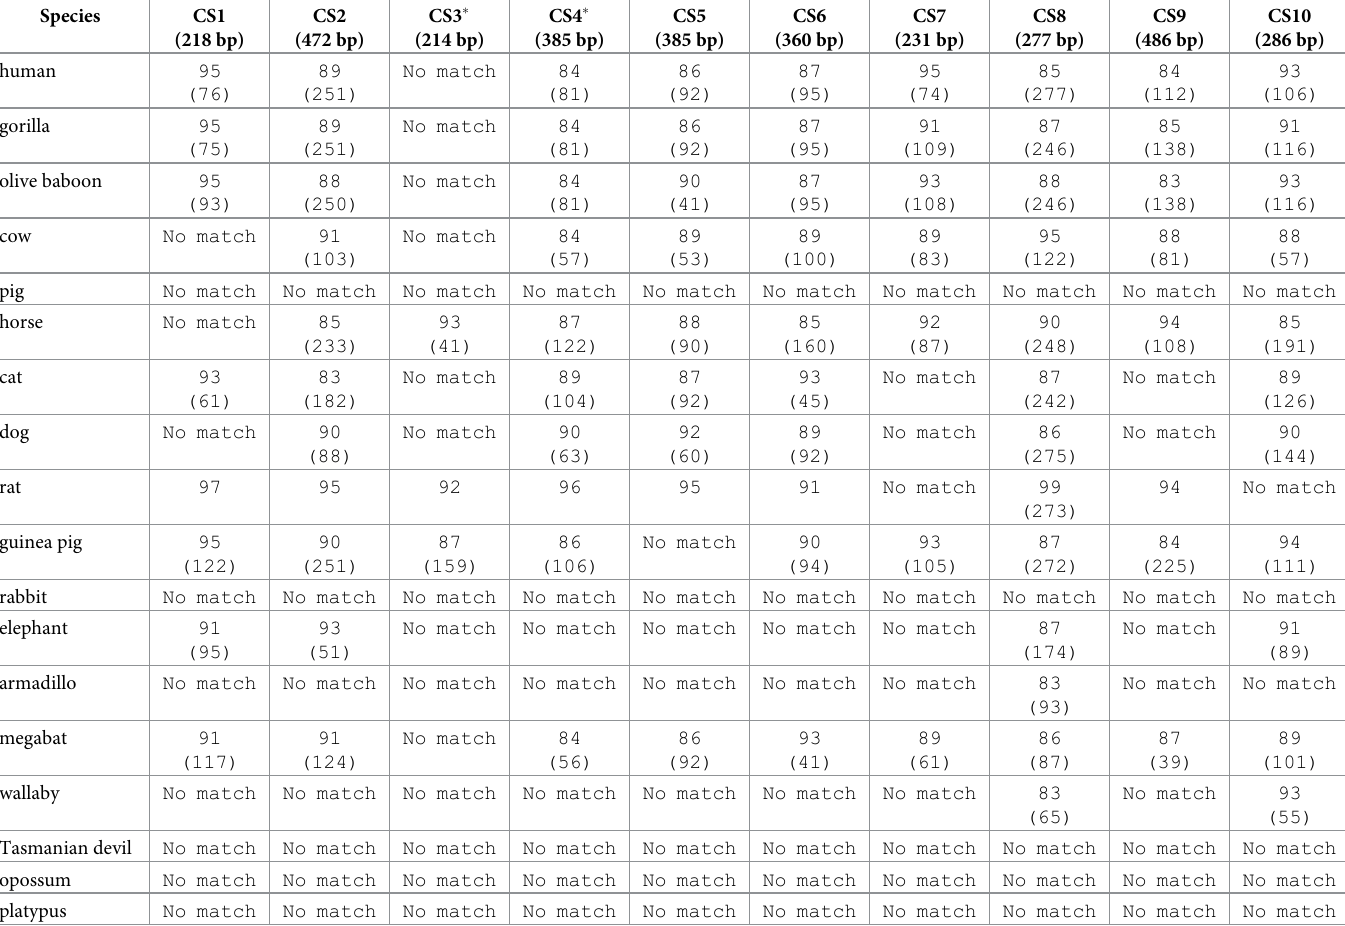
Table 4. Percent nucleotide identity with mouse Igf2-H19 locus enhancers ¶ . Species